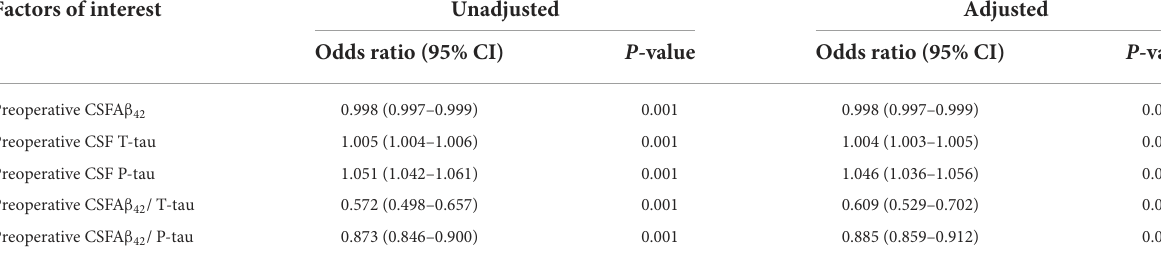
TABLE 3.2 Logistic analysis for risk factors of MCI patients.